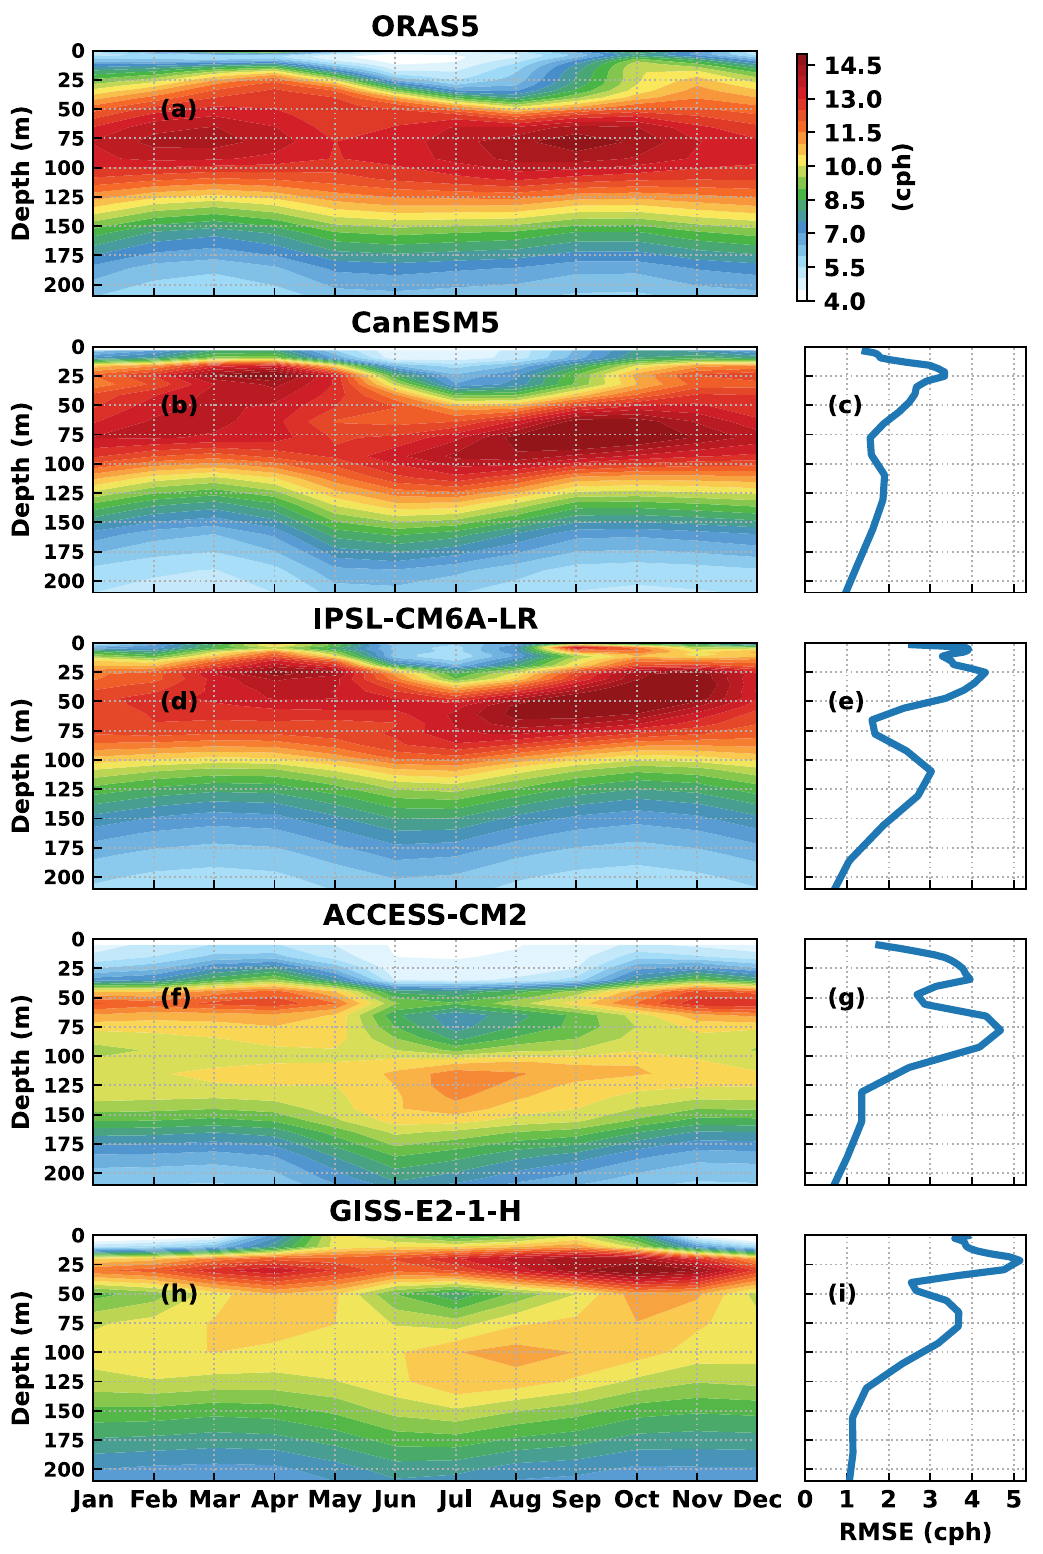
Fig. 8 Validation of CMIP6 data. Comparison of the annual cycle of density strati fi cation pro fi les in the Andaman Sea between ( a ) ORAS5 and historical simulations of ( b ) CanESM5, d IPSL-CM6A-LR, f ACCESS-CM2, h GISS-E2-1-H during 1993 – 2015. The root mean square error (RMSE) of monthly strati fi cation at different depths between ORAS5 and CanESM5, IPSL-CM6A-LR, ACCESS-CM2, GISS-E2-1-H is shown in ( c , e , g , i ), respectively.